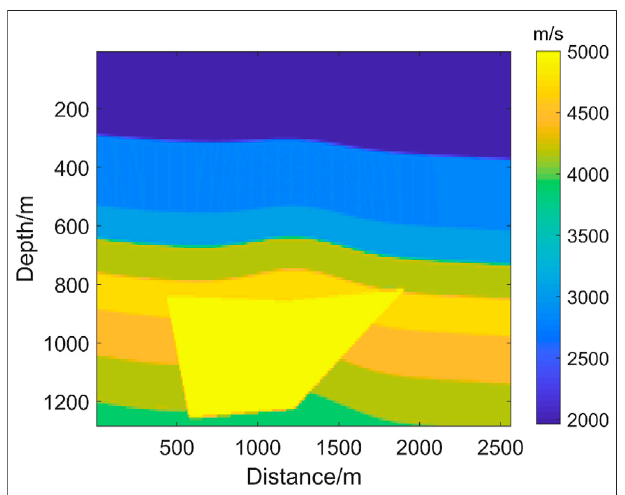
FIGURE 1 | Randomly generated velocity model.